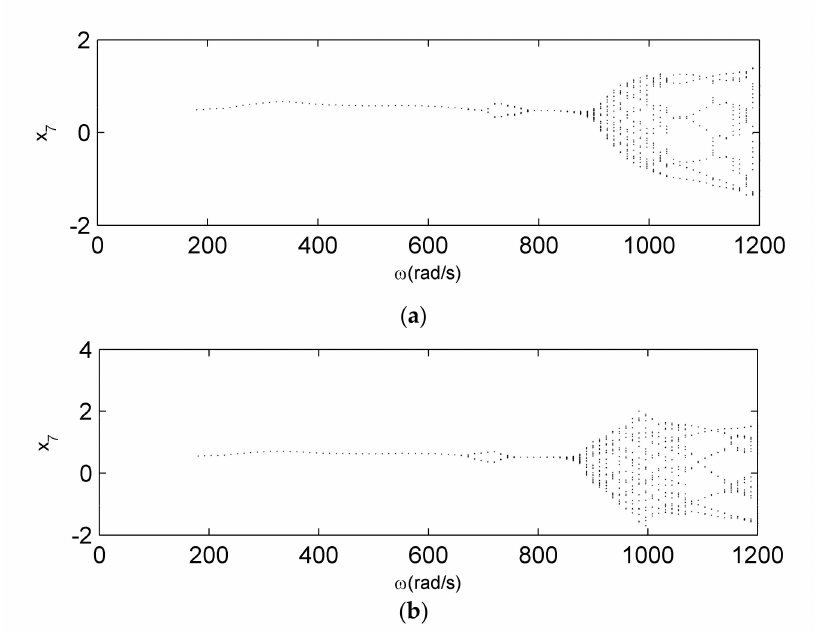
Figure 18. Bifurcation diagrams for coupled fault system. ( a ) k = 500. ( b ) k = 1000.